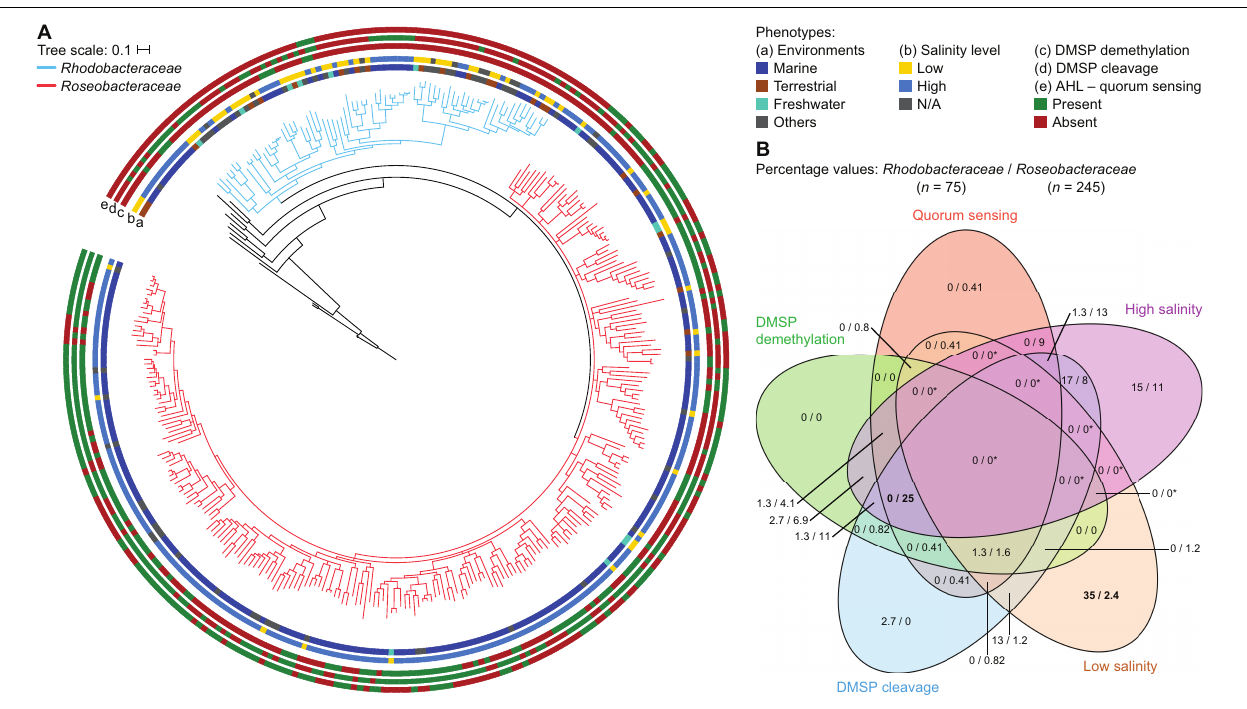
FIGURE 7 | Differences between Rhodobacteraceae and Roseobacteraceae fam. nov. based on environment of isolation and phenotypic traits. (A) On the core-genome phylogenetic tree (same as Figure 2 ), branches of the families Rhodobacteraceae and Roseobacteraceae fam. nov. are highlighted in blue and pink, respectively. The scale bar represents amino acid substitutions per site. Rings represent the (a) environment of isolation – marine (blue), terrestrial (brown), freshwater (light blue), and others (gray); (b) salinity levels – high: ≥ 3.5% NaCl, light blue; low: < 3.5% NaCl, yellow; and the presence (green) or absence (red) of (c) DMSP demethylation pathway, (d) DMSP cleavage pathway, and (e) AHL-quorum sensing. (B) Venn diagram showing percentage of isolates that are positive for each phenotypic trait considered. Since isolates are categorized to belong to either a high or a low salinity environment but never both, regions overlapping high and low salinity will always be 0/0 (and indicated by asterisks; otherwise, true 0/0 values are not). Numbers in bold highlight phenotype(s) most useful in distinguishing the two families (i.e., largest difference in percentage between the two